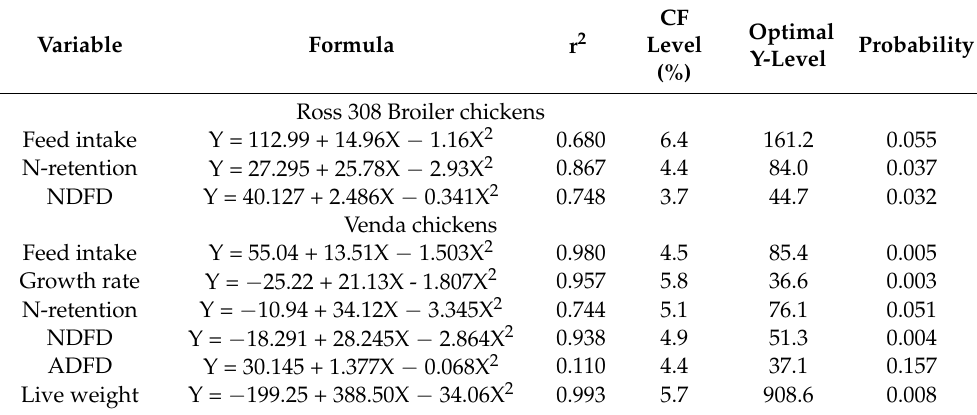
Table 7. The dietary crude fiber levels for the optimal production performance of the male Ross 308 broiler and Venda chickens aged 22 to 42 days.